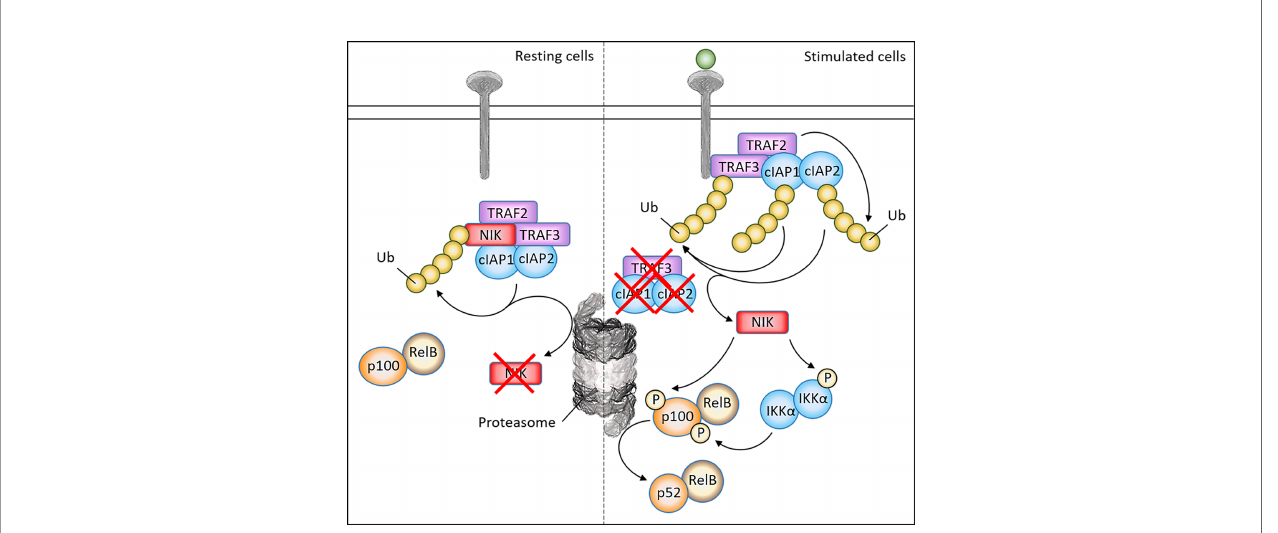
FIGURE 1 | Schematic overview of non-canonical signaling pathway and NIK regulatory mechanisms. In resting cells, NIK forms a complex with TRAF2/3 and cIAP1/2, which leads to the continuous ubiquitination and proteasomal degradation of NIK. Upon ligand binding, TRAF3 is recruited to the receptor, where TRAF2 induces ubiquitination of cIAP1/2 which in turn induces ubiquitination of TRAF3. As a result, TRAF3 is degraded and NIK is stabilized. After NIK stabilization, NIK is able to phosphorylate the IKK a complex to induce activation. After direct phosphorylation of the precursor p100 by both NIK and the IKK a complex, p100 will undergo proteasomal processing into the active subunit p52, which together with RelB may translocate to the nucleus to activate target